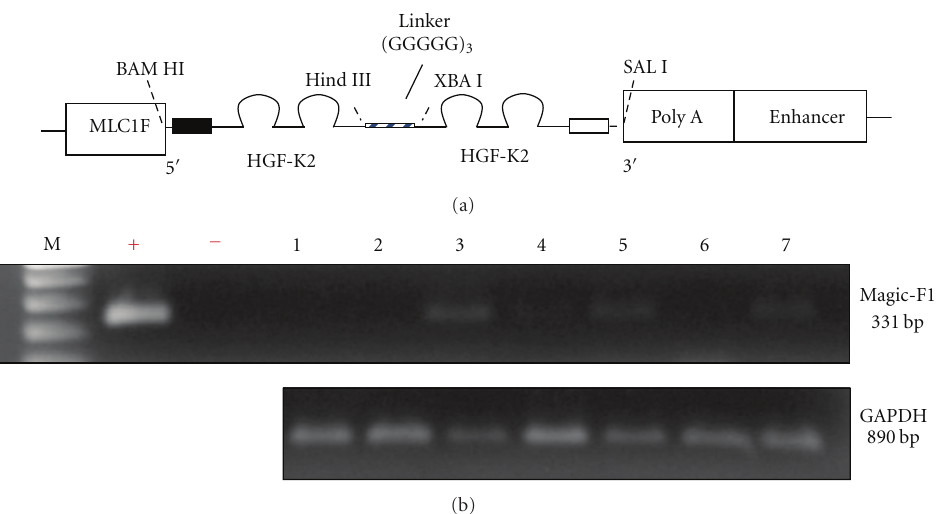
Figure 1: Magic-F1 transgenic mice. (a) Schematic representation of transgene. (b) Genotyping of 13.5 dpc mouse embryos derived by hemizygous-matched mice; +, − positive and negative control, respectively.